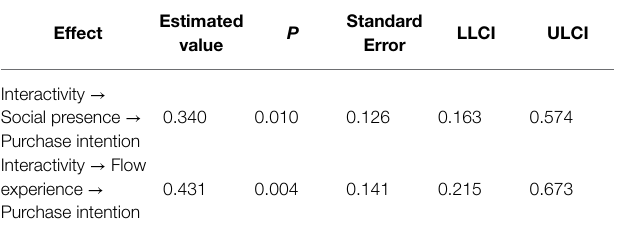
TABLE 2 | Mediating effect